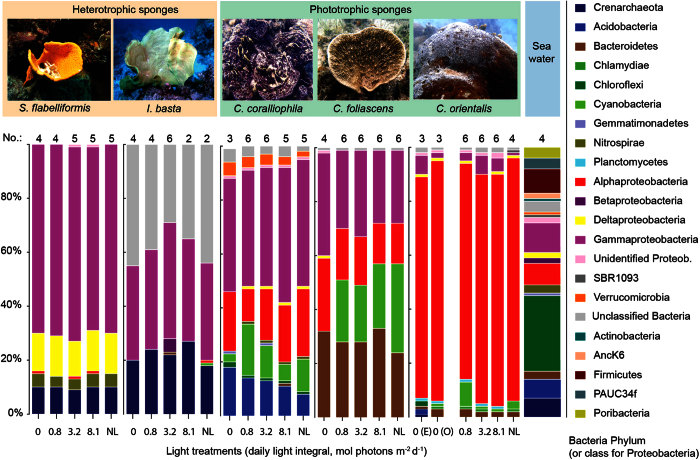
Phylum-level bar chart.Average relative abundance of each bacteria phylum (and class for Proteobacteria) for each species and light treatment (0, 0.8, 3.2, 8.1 mol photons m−2 d−1 and natural light: NL, 3.2–6.5 mol photons m−2 d−1). Only OTUs representing greater than 1% of the overall community were included. When significant differences in time were detected, samples from experimental (E) and observational (O) periods were plotted separately (i.e., 0 mol photons m−2 d−1 in C. orientalis, Table 3).